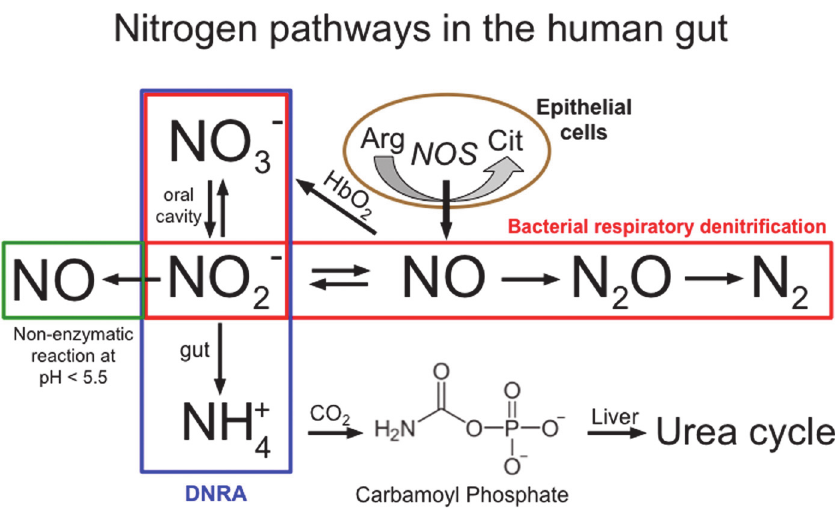
Fig 5. Schematic representation of the link between different pathways of nitrogen oxides reduction in the human gut and the fate of ammonia. Each colored box represents a distinct pathway: Bacterial respiratory denitrification to dinitrogen in red box: the dissimilatory nitrate reduction to ammonia (DNRA) in blue box and the non-enzymatic conversion of nitrite to NO in green box (this route become significant only at pH < 5.5). The endogenous L-arginine/NO synthase pathway from epithelial cells of the intestinal mucosa lining is also